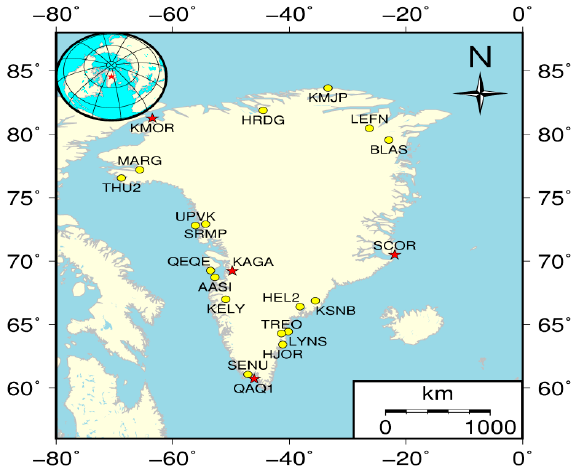
Figure 1. Distribution of GPS coordinate sites in Greenland.